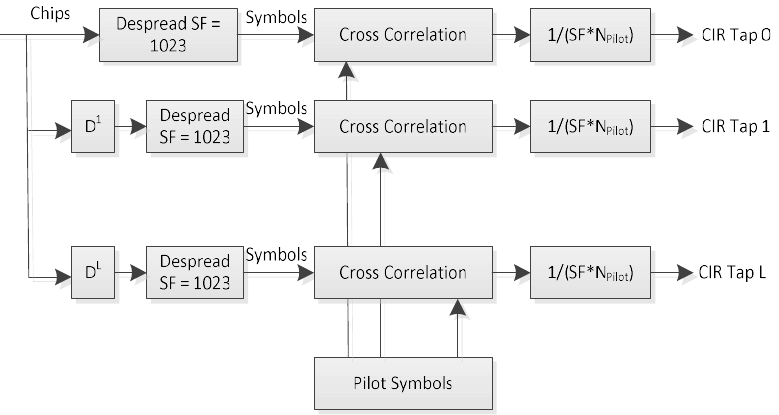
Figure 4. Correlation-based channel estimation.